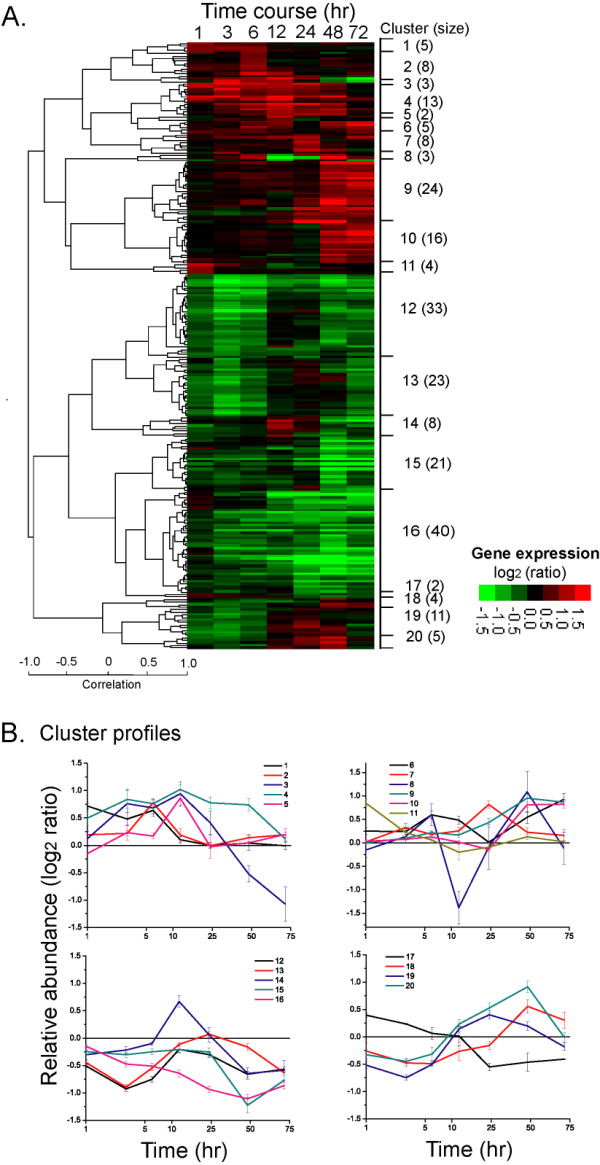
Cluster analysis of temporal transcriptional response elicited by S withdrawal (-SO42-/-HEPES). A. A heat map of a hierarchical cluster of genes significantly affected by S deprivation. A gene was deemed significantly affected if its transcript level deviated from a 0-hr level by at least 50% in at least 1 time point across the time course (FDR<0.01). Hierarchical clustering was performed by complete linkage algorithm using Pearson correlation as a similarity metric. The log2 (ratio) of each gene is represented according to the shown color scale. 20 clusters were delineated based on a correlation coefficient (r) cut-off of 0.50, shown to the right of the heat-map. Numbers given in parentheses represents the number of genes contained in each cluster. B. The transcriptional profile of each cluster. The data are represented as a mean ± s.e.m.